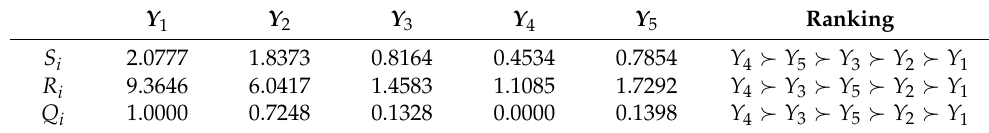
Table 2. The ranking results of selected